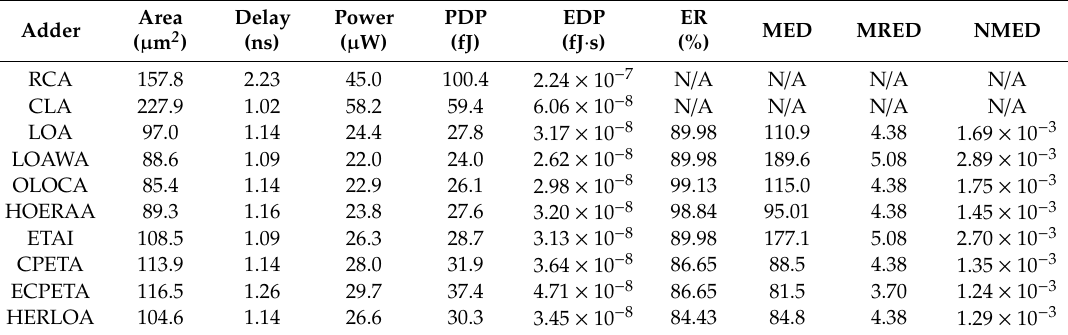
Table 1. Summary of performances of various 16-bit adders with n = 16 and k =